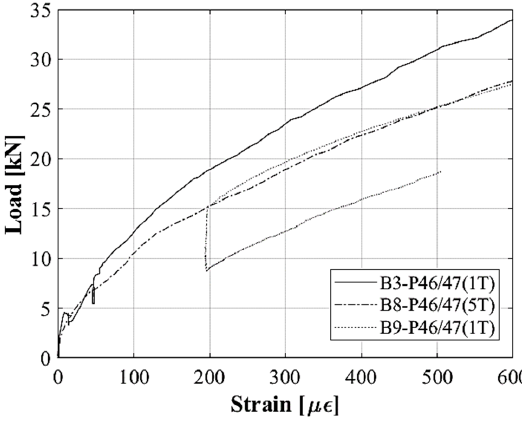
Figure 16. Applied load versus crack reopening.